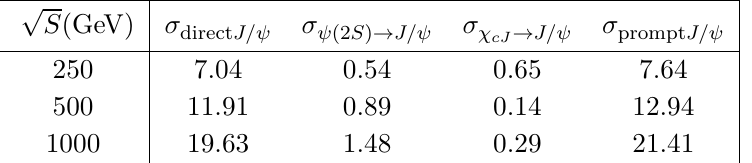
Table 1 . The integrated cross sections (in unit of pb) for prompt J/ψ photoproduction under different collision energies at the ILC. The cut p t > 5 GeV is set for J/ψ . Both the CS and the CO channels have been summed